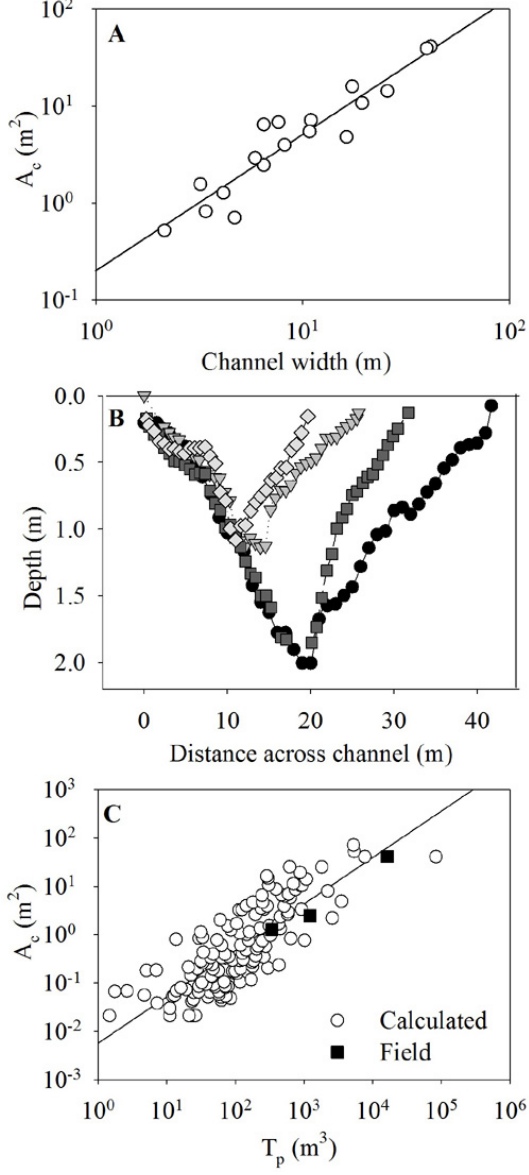
Fig. 5. Calculated spring tidal prism for tidal freshwater wetlands. (A) Relationship between inlet width and cross-sectional area. (B) Inlet channel cross-sectional areas plotted relative to the ele- vation of the marsh platform. Inlets with widths > 16m experience